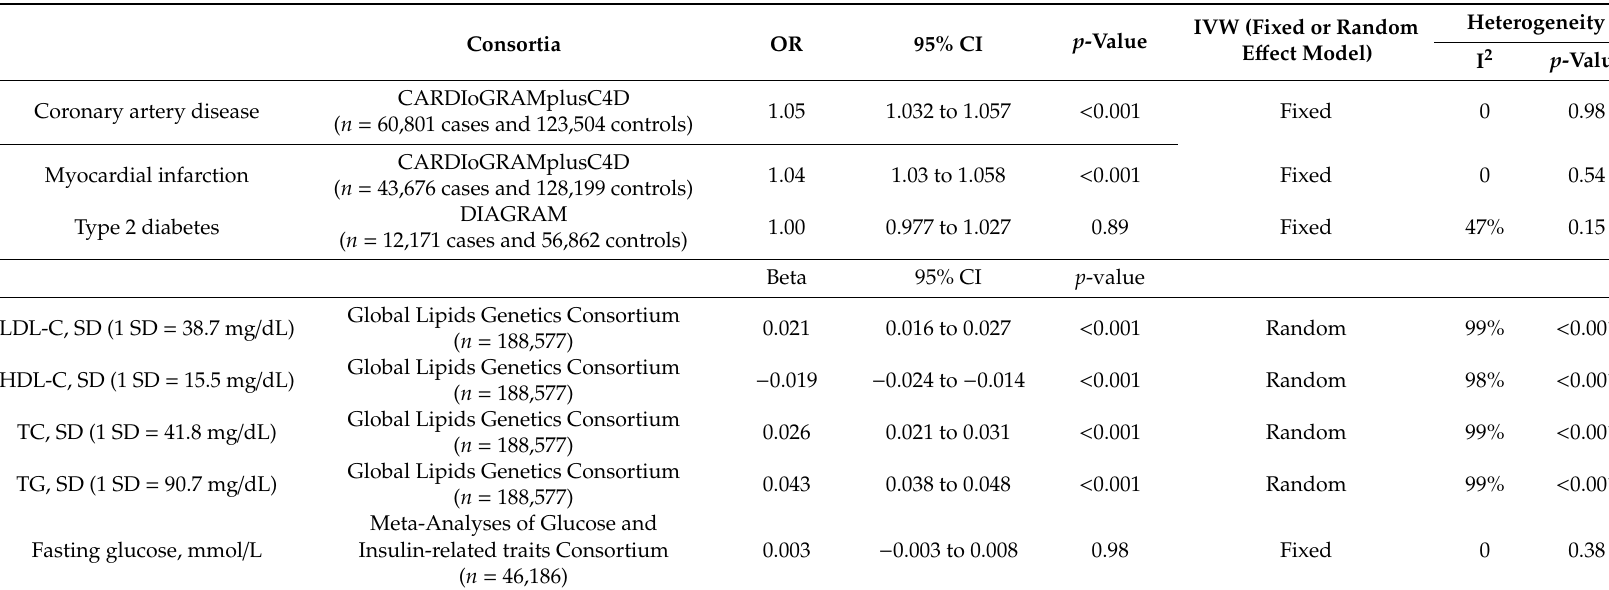
Table 2. MR estimates of causality between vitamin E levels (mg / L) and cardiovascular risk factors, diabetes, and coronary artery disease based on 3 SNPs using fixed or random IVW model according heterogeneity